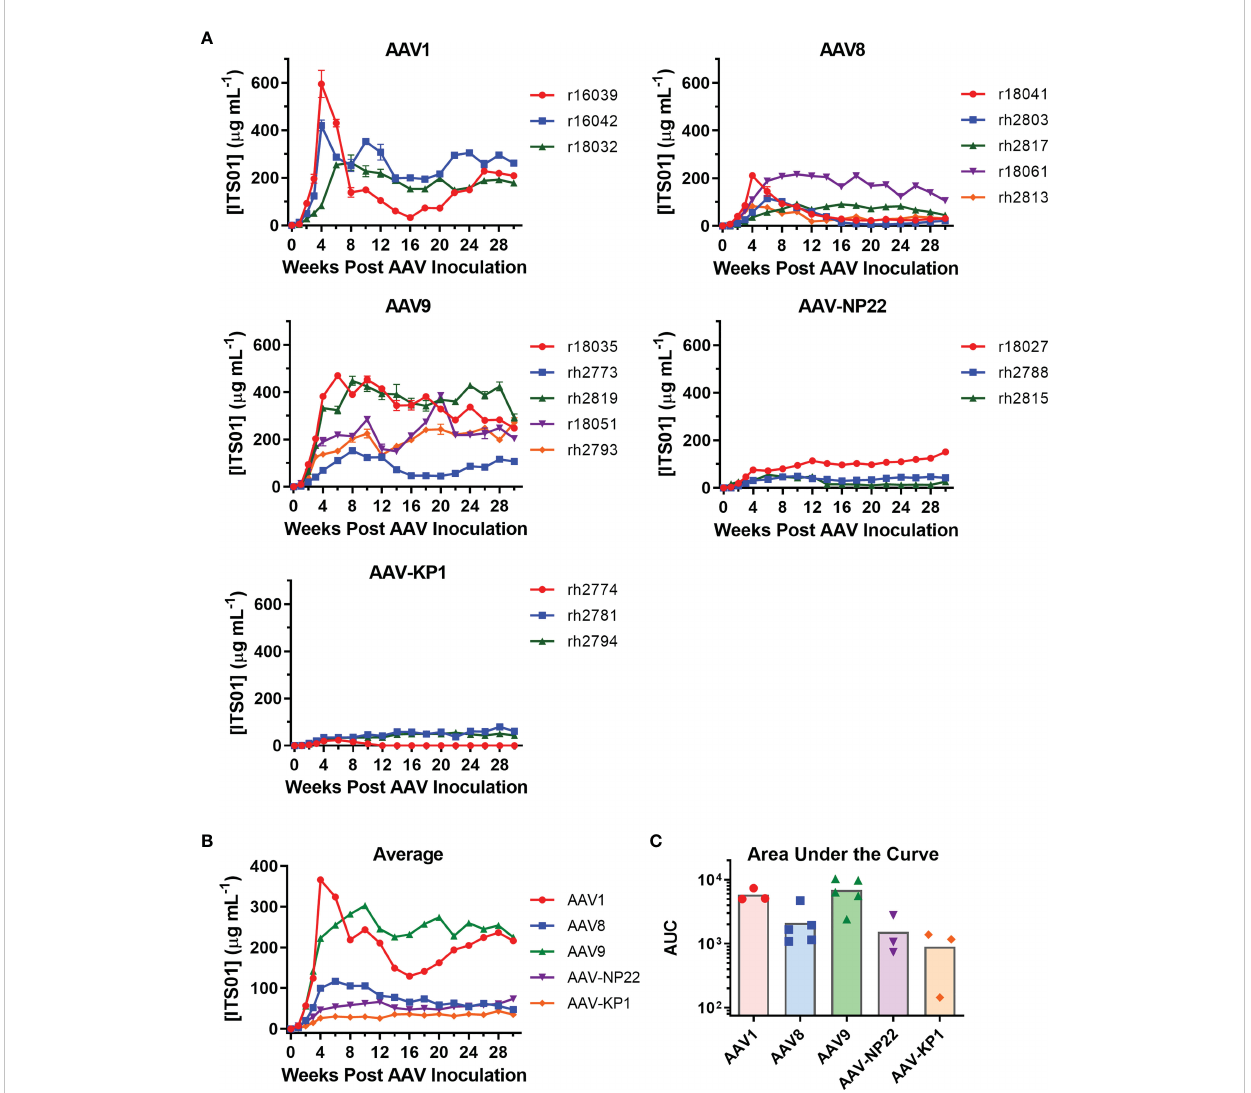
FIGURE 4 Comparison of ITS01 concentrations from rhesus macaques with different AAV vectors. (A) Quanti fi cation of ITS01 concentration from AAV vectors with AAV1, AAV8, AAV9, AAV-NP22, and AAV-KP1 capsids. Five groups of three or fi ve macaques each were inoculated with 2.5×10 12 vg/kg of the indicated AAV vector in eight injection sites per macaque. ITS01 concentrations for the AAV1, AAV8, AAV9, AAV-NP-22, and AAV-KP1 groups were measured over the course of 30 weeks by SIVsmE660 gp120 ELISA. (B) The average ITS01 concentrations for each group are represented. (C) The average area under the curve (AUC) as for each capsid group is represented with each individual icon representing an animal from that capsid group. Error bars indicate S.D. in (A, B)